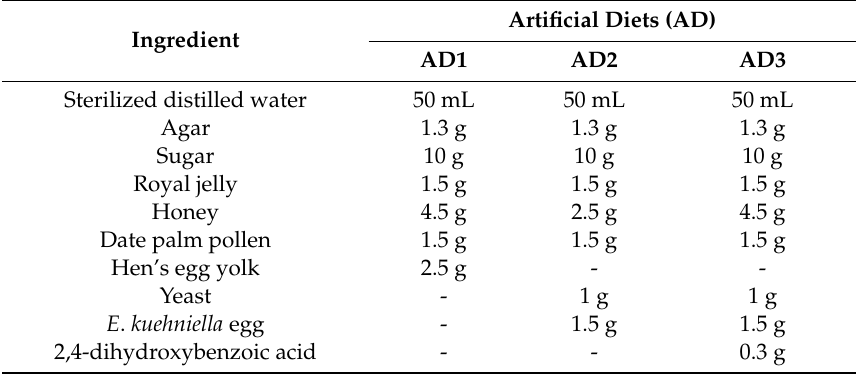
Table 1. Ingredients of three artificial diets supplied to S. gilvifrons.